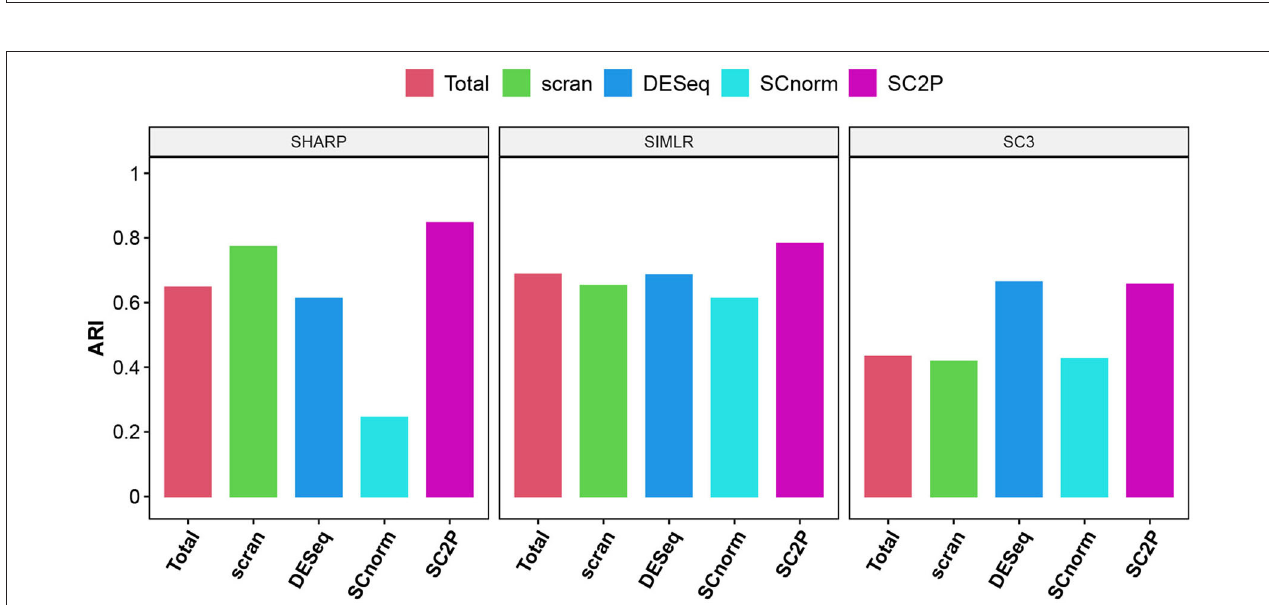
FIGURE 7 | The adjusted Rand index (ARI) using three different clustering methods with different normalization. Genes that are detected in at least three cells are used in clustering.